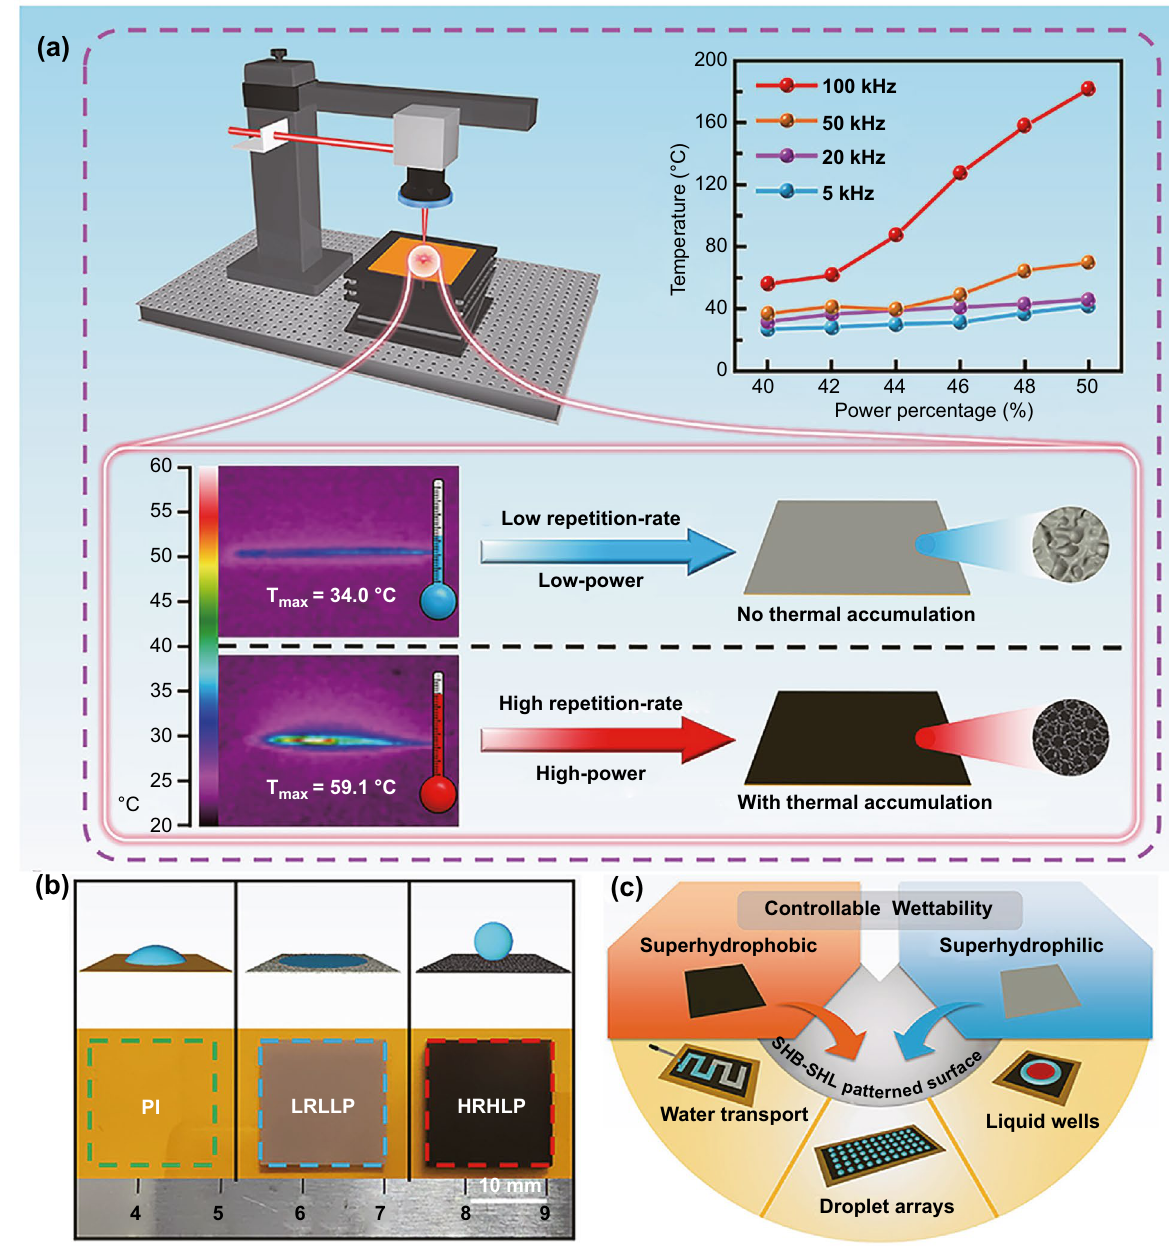
Fig. 1 a Schematic diagram of the preparation of the laser-treated PI film. Maximum temperatures of treated PI film with different repetition rates and power percentages are shown on the upper right corner. b Optical photographs for pristine PI film, two types of laser-treated PI films and their surface wettability. c Various potential applications of superhydrophilic–superhydrophobic patterned